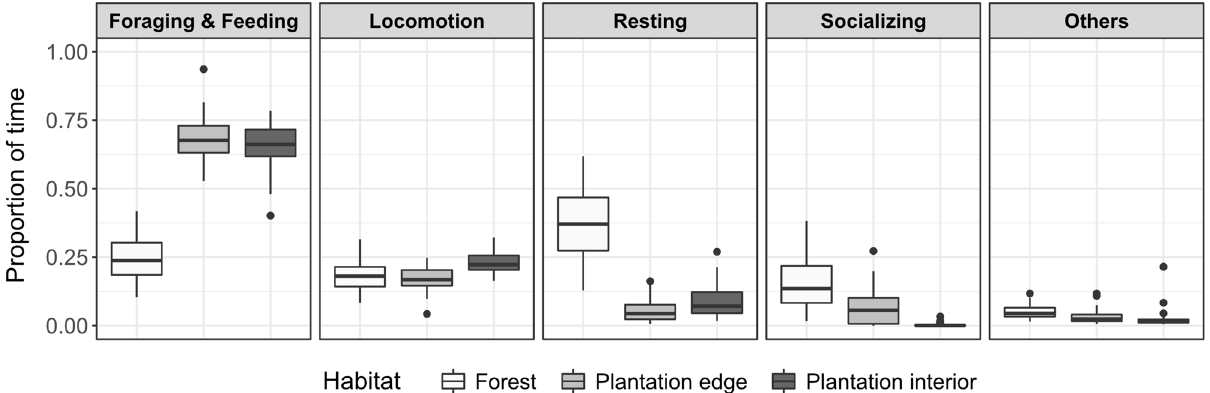
Figure 2. Activity budgets of Macaca nemestrina in forest and oil palm plantation. The boxplots indicate the median values and percentiles of individual proportions of time spent for foraging and feeding, locomotion, resting, socializing and other behaviours (e.g. self-directed behaviour, agonistic behaviour, mating), separately for forest, plantation edge and plantation interior. Circles represent outliers. The sample comprised a total of 50 individuals belonging to two social